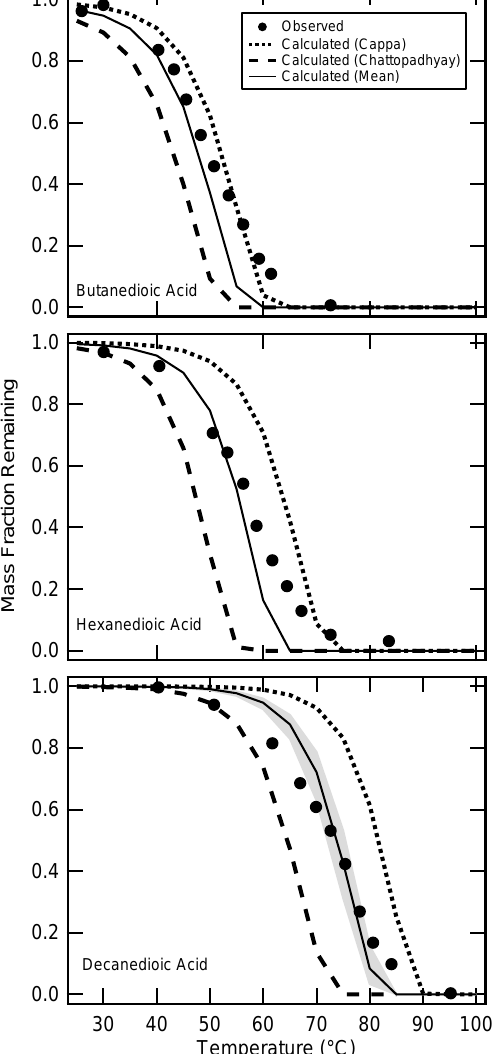
Fig. 2. Calculated mass fraction remaining (referenced to bypass) for butanedioic, hexandioic and decanedioic acid compared to ob- servations by Faulhaber et al. (2009). The thermodynamic param- eters ( C sat and 1H vap ) used are from Cappa et al. (2007) (dotted), Chattopadhyay and Ziemann (2005) (dashed) or the average of the two (solid). The model was run using d p =200nm, t res =16s, γ e =1 and C OA =150µg/m 3 . For decanedioic acid the gray region shows the range for 100µg/m 3 <C OA < 200µg/m 3 .